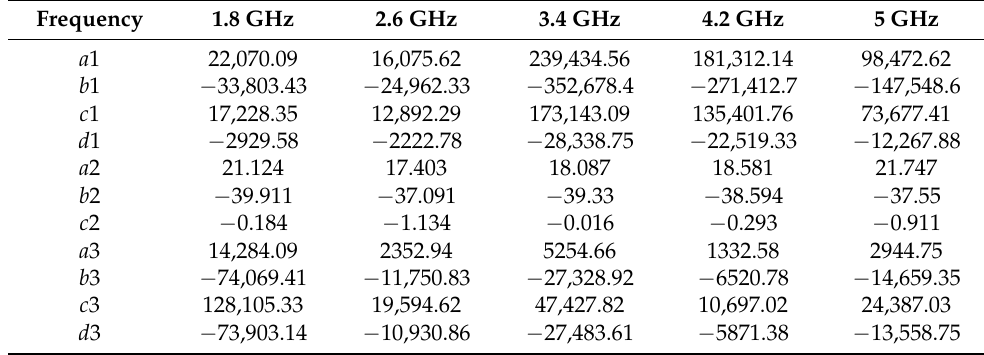
Table 2. Values of the